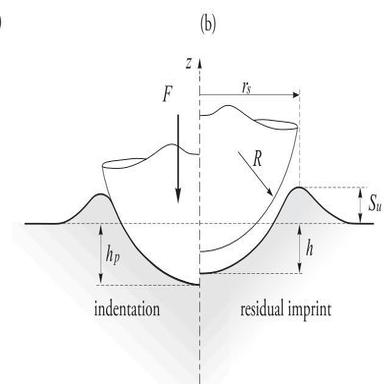
The schematic representation of the instrumented ball indentation test. In the first step, the sheet is indented with a ball indenter to achieve a maximum prescribed force (a). At the maximum force, the depth hp is reached. The loading process is followed by the elastic unloading (b). In this step, the anisotropy-characteristic pile-up height Su is measured at the radius rs for a number of different angles to the rolling direction θ.